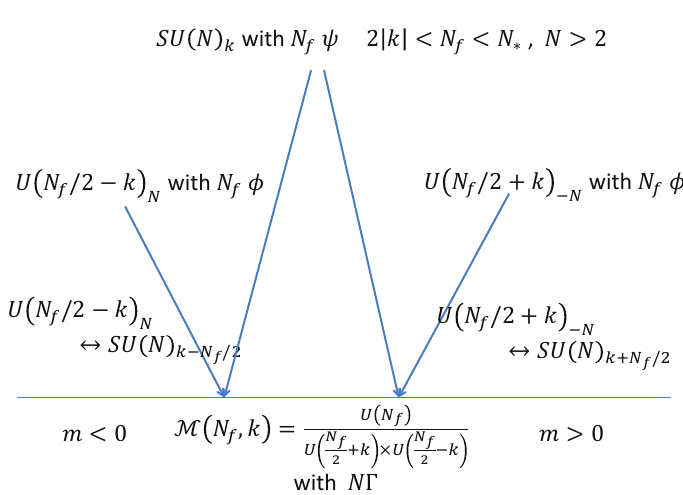
Figure 2 . The phase diagram of SU( N ) k for 2 j k j < N f < N (cid:3) . The gapped phases have topological (cid:12)eld theories, SU( N ) , which are related by level-rank duality of spin theories to U( N f = 2 (cid:6) k (cid:6) N f = 2 k ) (cid:7) N . The middle gapless phase is a nonlinear sigma model on a Grassmannian with a Wess-Zumino term (cid:0), whose coe(cid:14)cient is N . For N = 2 the Grassmannian is replaced by Sp( N f ) = (Sp( N f = 2 + k ) (cid:2) Sp( N f = 2 (cid:0) k